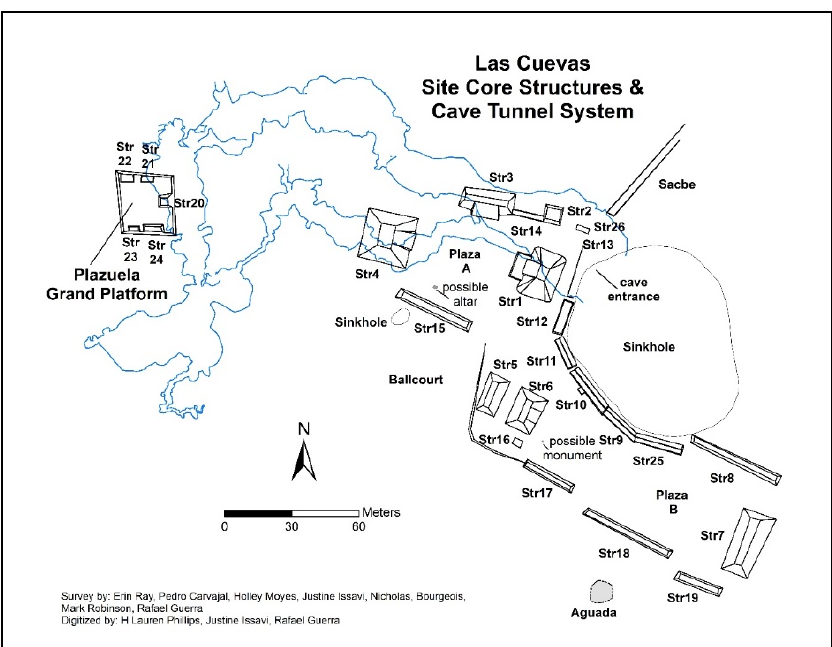
Figure 1. Belize map illustrates location of project area within the Chiquibul Forest Reserve.